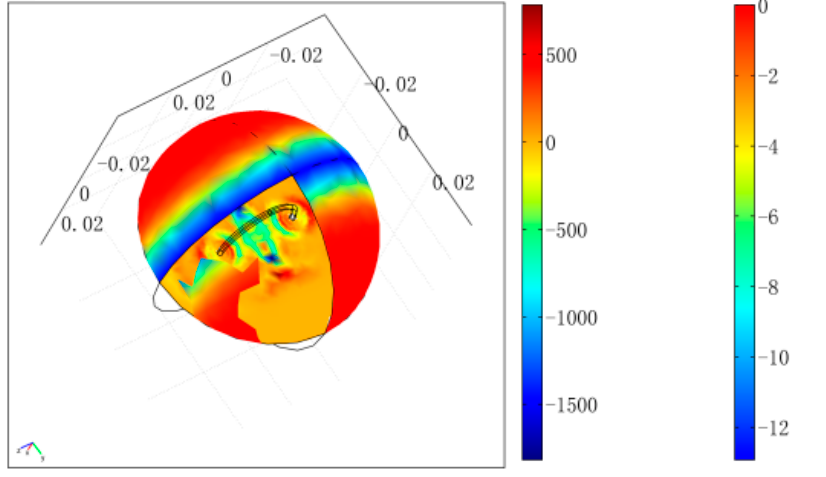
Figure 8. Distribution of sound pressure on the section and boundary of the 3-d model.